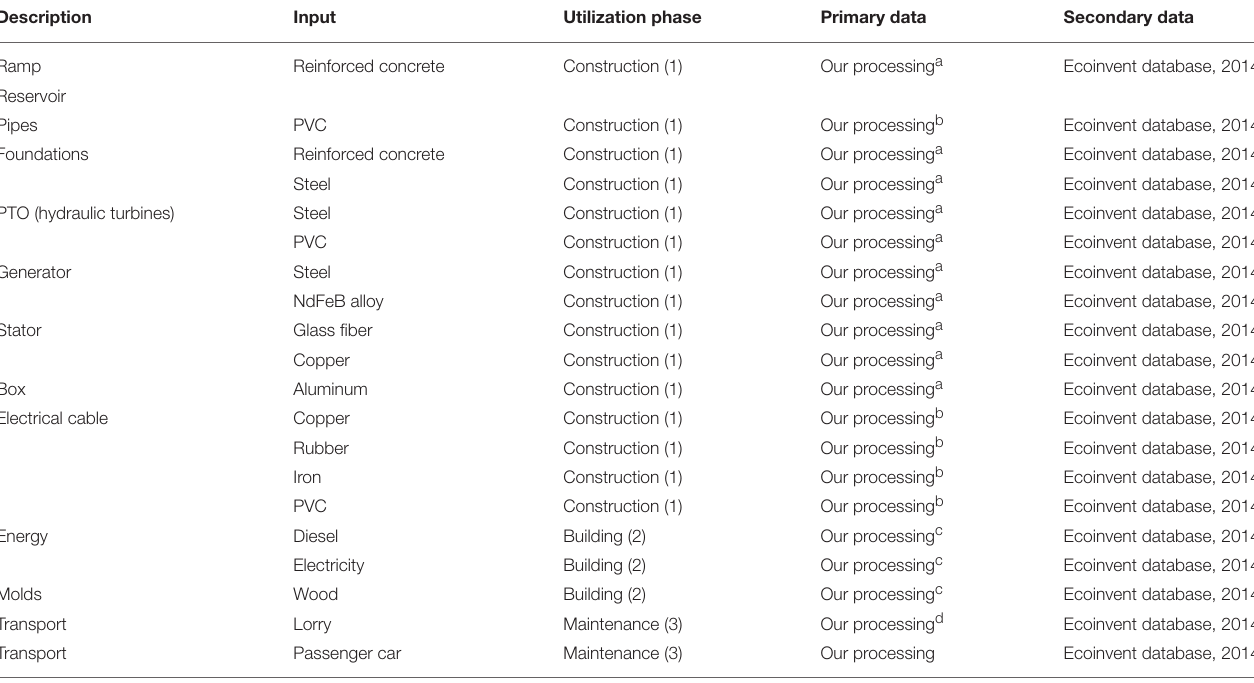
TABLE 1 | Primary and secondary data sources used in the LCA of the OBREC